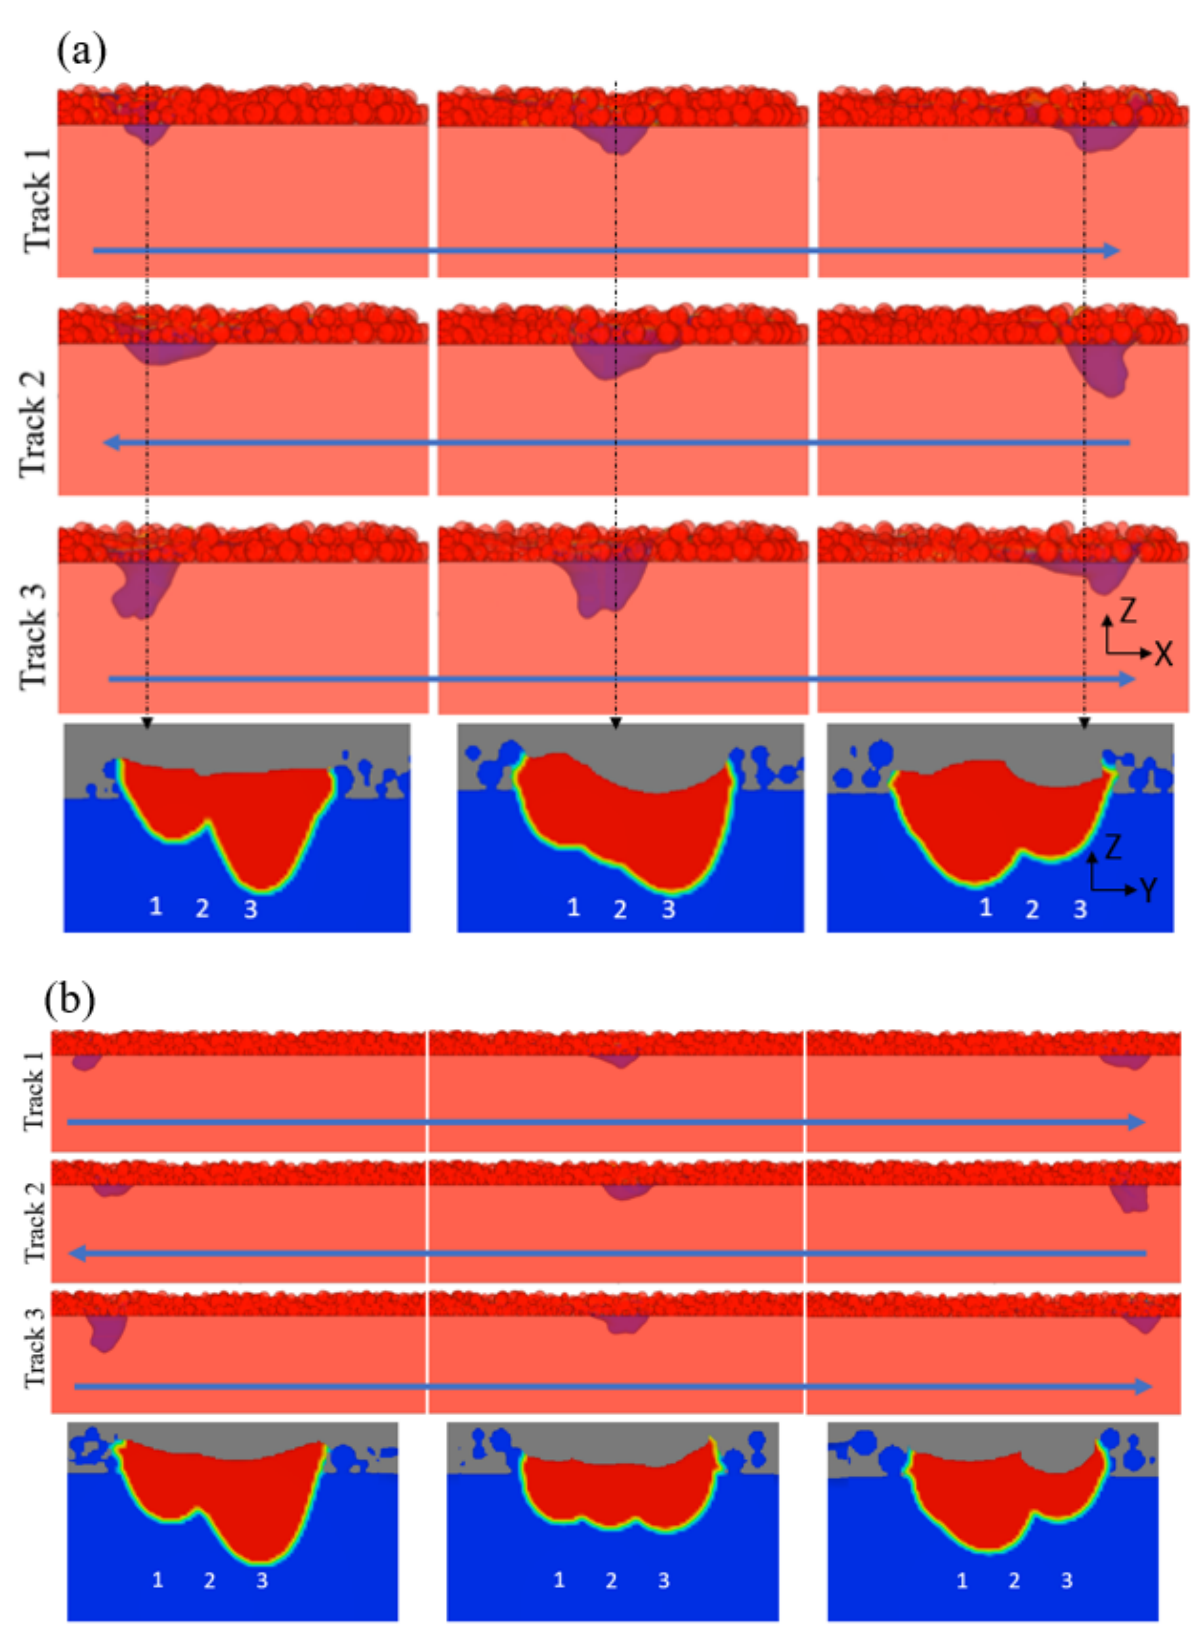
Figure 15. Evolution of melt pool and vapor depression with 195 W laser power, 750 mm/s scan speed, 80 µm hatch spacing, and scan lengths of ( a ) 0.5 mm and ( b ) 1.0 mm.